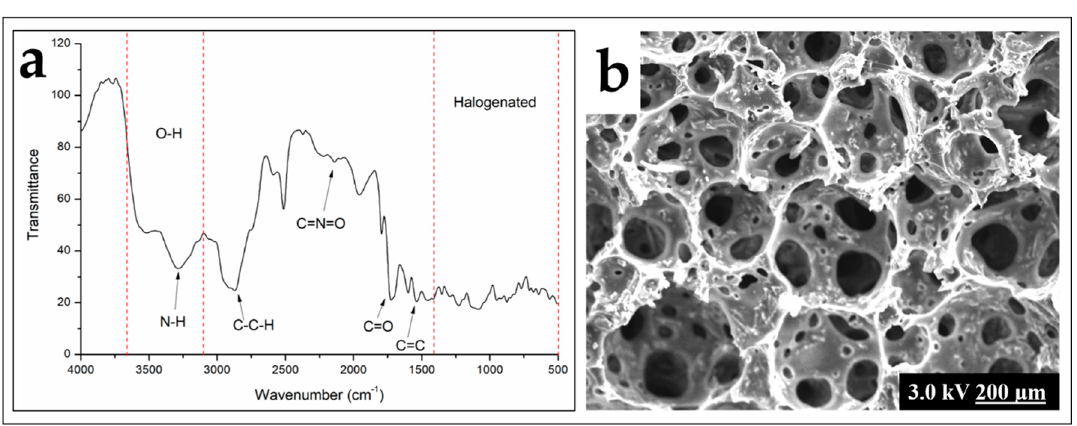
Figure 12. ( a ) Functional groups and ( b ) morphology characteristics of commercial PUF respectively analyzed with FTIR and SEM (200× magnification).